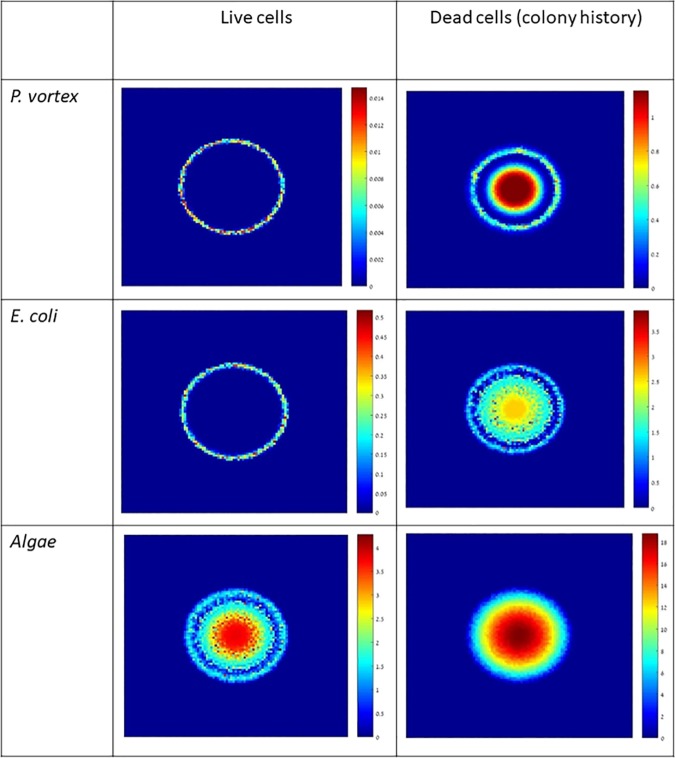
Simulation results for a 3-species system.